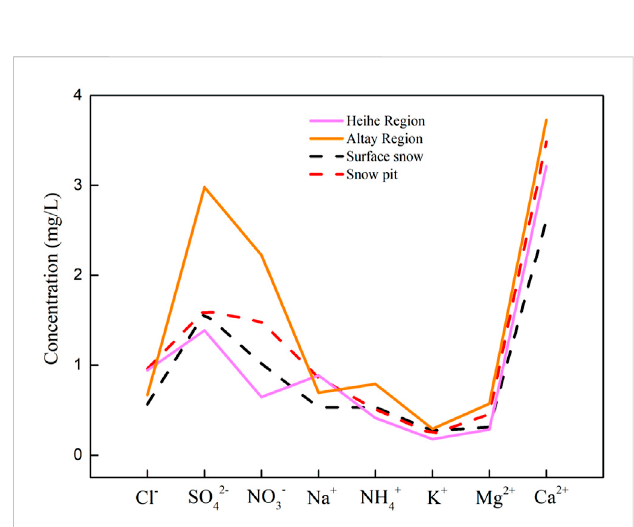
FIGURE 4 Comparison of mean values of ion concentrations in snow from differentregionsandtypesofsamples.Theblackandreddottedlinesare the average values of ion concentrations in surface snow samples and snow pits, respectively. The pink and orange solid lines are the average values of ion concentrations in snow in Heihe and Altay,